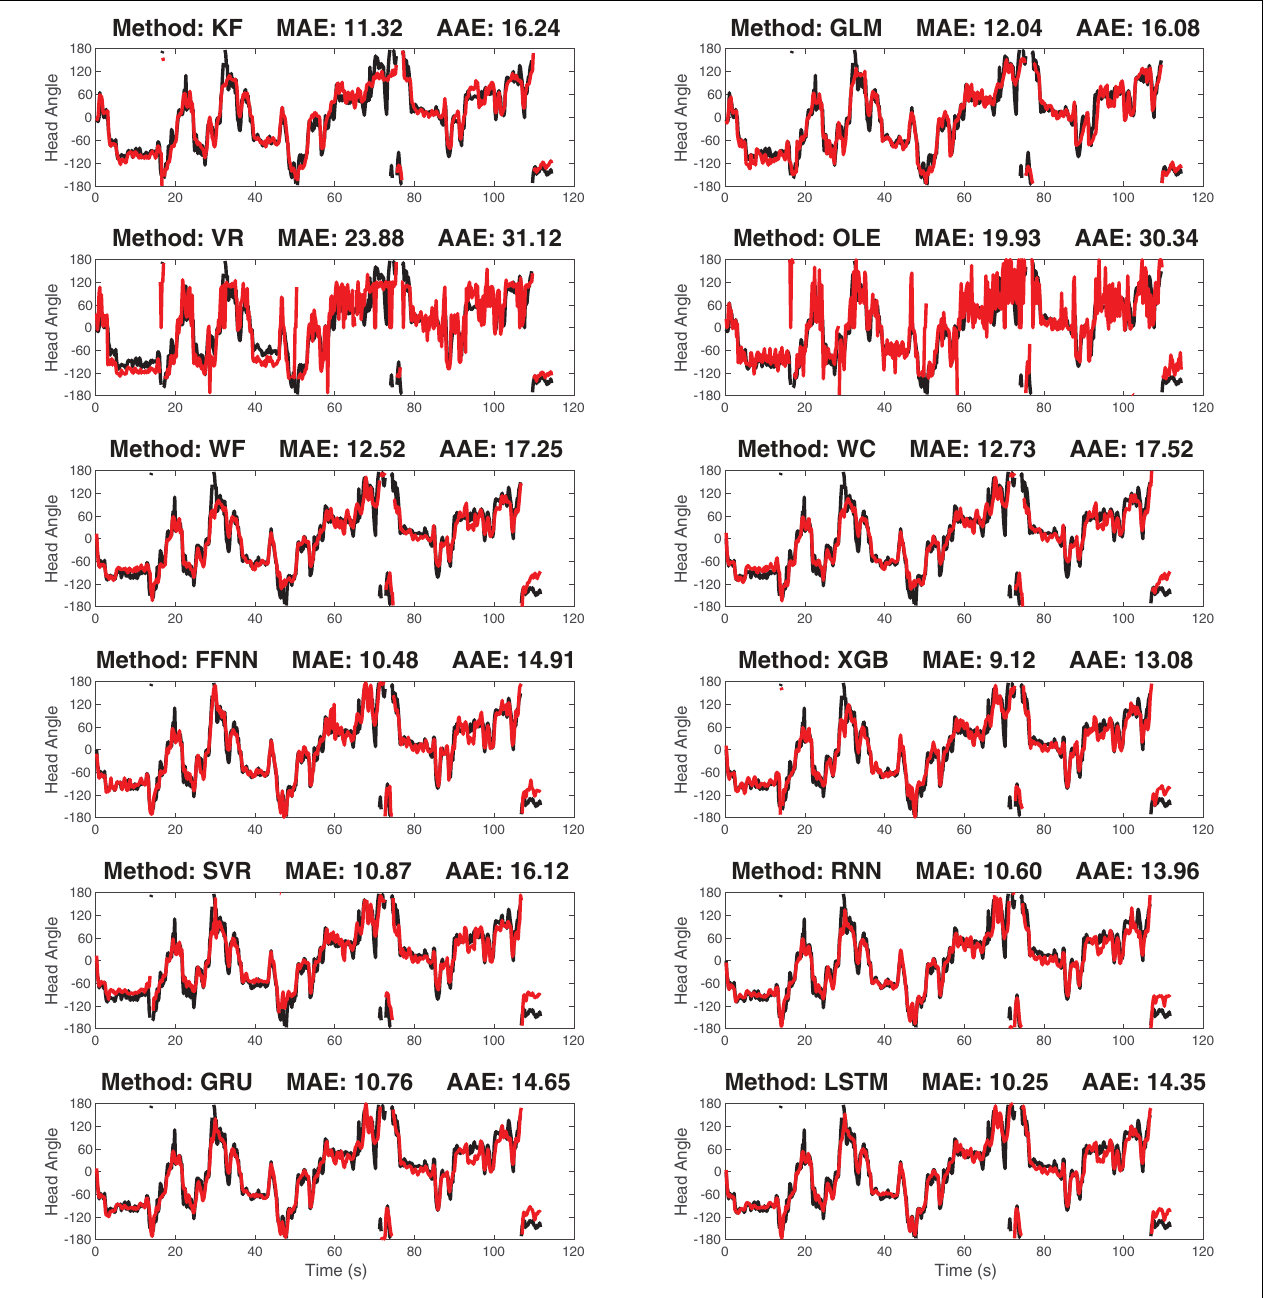
FIGURE 6 | The true-vs.-predicted head angle plotted as a function of time for a representative ATN dataset for each of the 12 decoding methods: The black curves are the true curves and the red curves are the predicted curves. Test data is shown. Predicted curves are constructed using a model generated from a separate training segment of the data. The method name and decoding accuracy measured as median absolute error (MAE) are shown on the title of each plot (average absolute error, AAE, is also shown). KF, Kalman Filter; GLM, Generalized Linear Model; VR, Vector Reconstruction; OLE, Optimal Linear Estimator; WF, Wiener Filte, and WC, Wiener Cascade. The remaining six are machine learning methods: SVR, Support Vector Regression; XGB, XGBoost; FFNN, Feedforward Neural Network; RNN, Recurrent Neural Network; GRU, Gated Recurrent Unit; LSTM, Long Short-Term Memory.